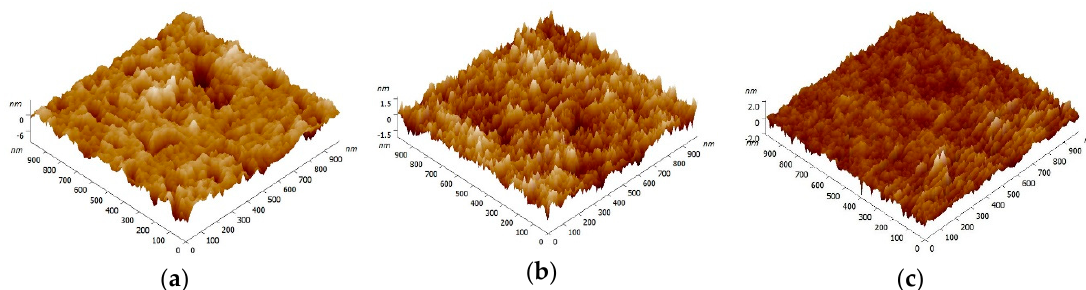
Figure 1. AFM images (1 μ m × 1 μ m) of glass substrate ( a ), CV-SiO 2 gel film ( b ), and SiO 2 gel film ( c ).